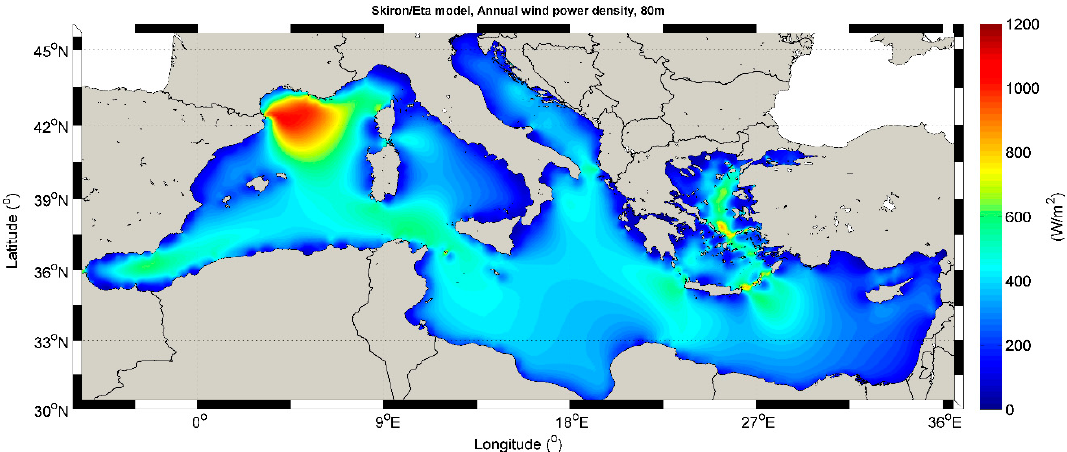
Figure 12. Mean annual offshore wind power density at 80 m height asl according to the ETA based atmospheric model. Data analyzed by HCMR. Energies 2017 , 10 , 1512